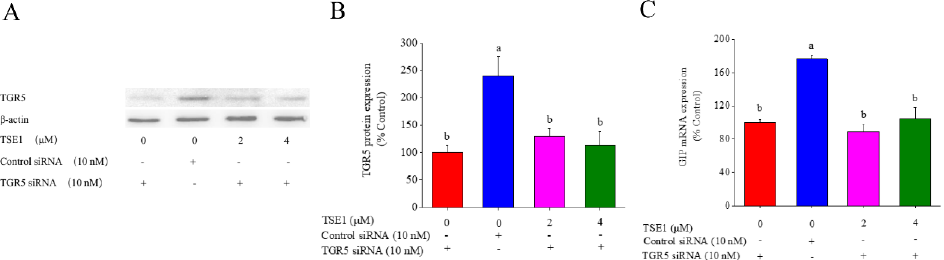
Figure 5. Role of TGR5 in TSE1-induced GIP expression in STC −1 cells. ( A ) Effect of TGR5 siRNA on the TGR5 protein expression determined by Western blot. ( B ) Quantification of protein bands analyzed by the ImageJ software. ( C ) Effect of TGR5 siRNA on the GIP mRNA expression determined by RT-PCR. Different letters indicate significant difference among groups ( p < 0.05).